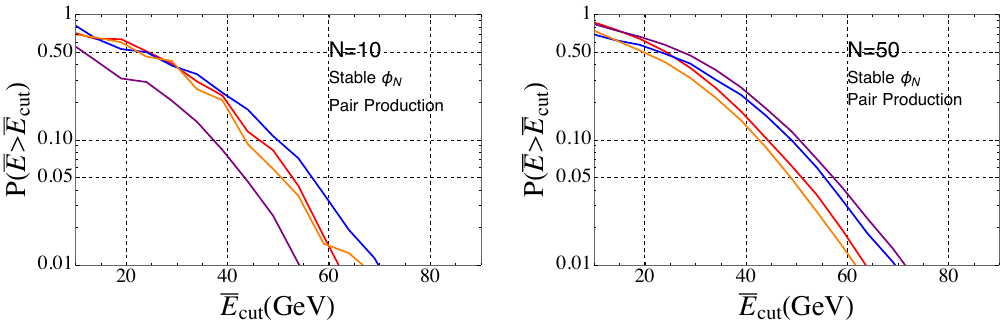
Figure 14. Fraction of events with average energy per particle above E in the Z -symmetric scenario where a SM = a = 0 in eqs. (3.1) and (3.2). Left: 10 scalars, right: 50 2 scalars.